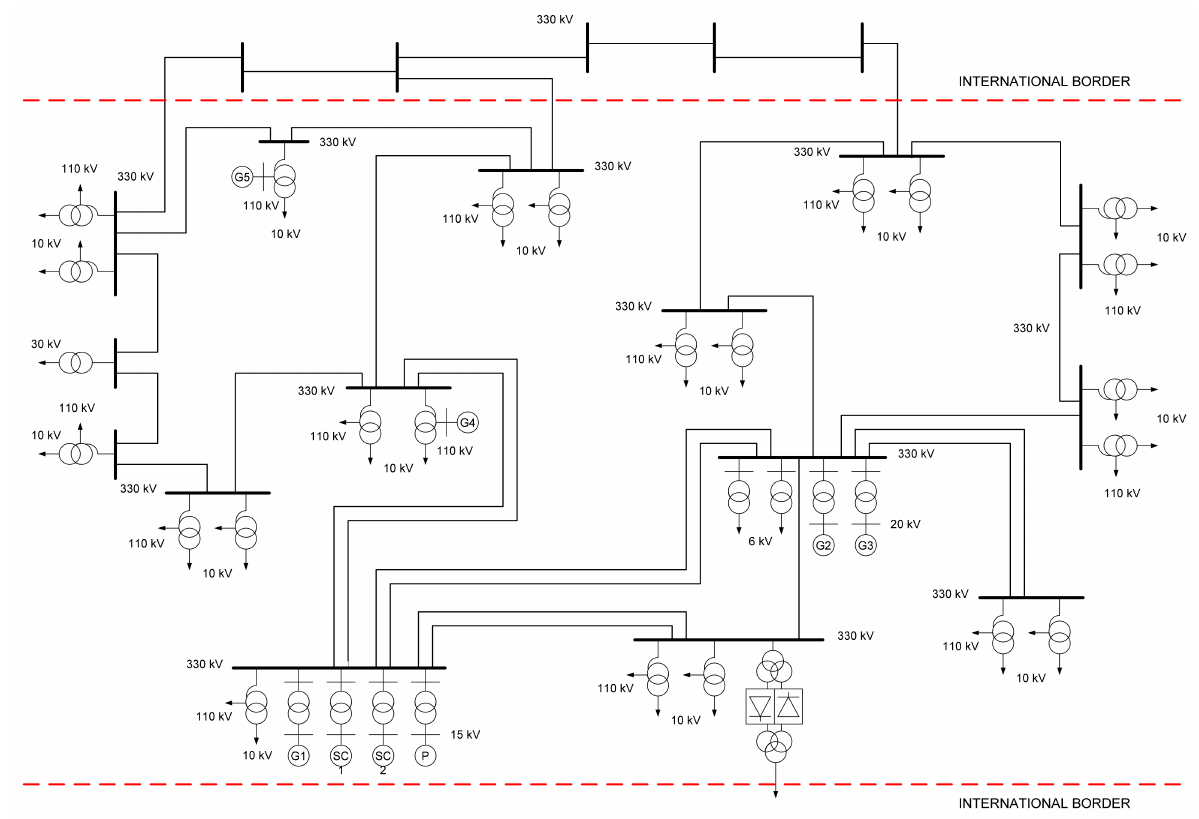
Figure 1. Isolated power system scheme.